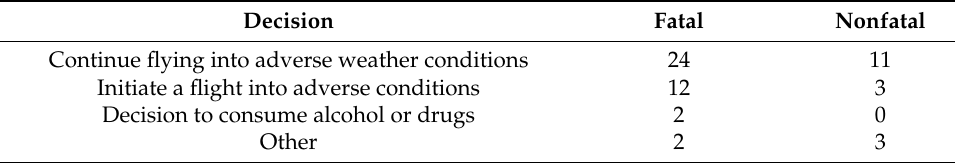
Table 3. The kinds of decision-making errors identified by the NTSB